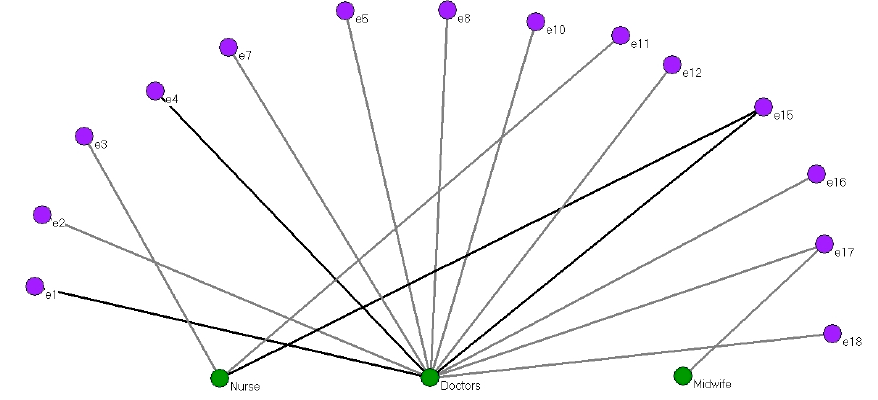
Figure 3. Two-mode network of care provided by health professionals (doctor, nurse or midwife).